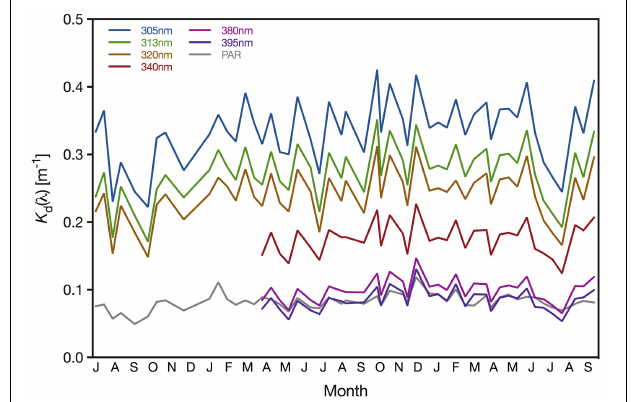
FIGURE 4 | Downwelling attenuation coefficients ( K d ) of 305, 313, 320, 340, 380, 395 nm and PAR (400–700 nm) determined for the pelagic sampling station (22.309333 ◦ N, 38.997389 ◦ E) offshore from KAUST. Measurements of the wavelengths 305, 313, and 320 nm and PAR started in July 2016, whereas the remaining wavebands were included after April